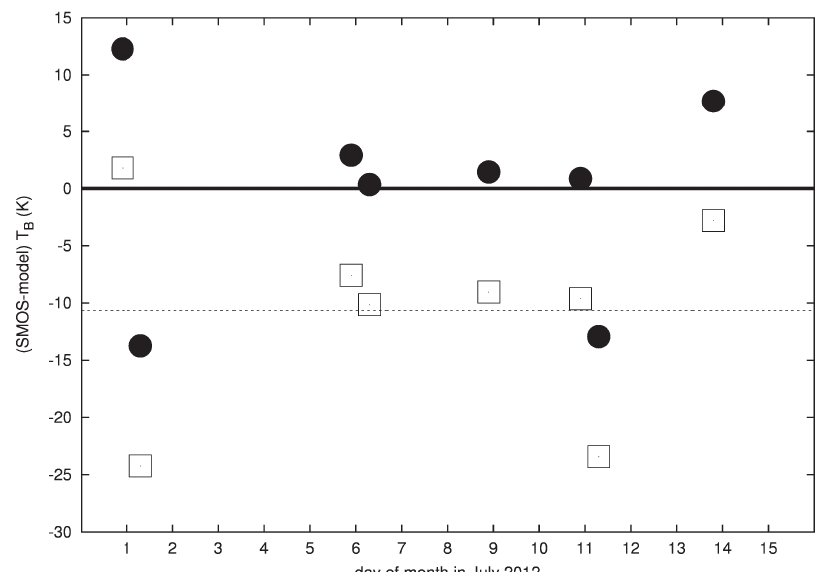
Figure 4. Difference between each SMOS observed T and the corresponding model B equivalent between 1 and 15 July 2012 in a location in central Australia [lat = (cid:0) 24.7780, lon = 132.031], before bias correction (squares) and after correction (filled dots). Observations were obtained in YY polarisation and in an incidence angle range between [39.5, 40.5]. The dashed line shows the averaged bias for this grid point before the correction was